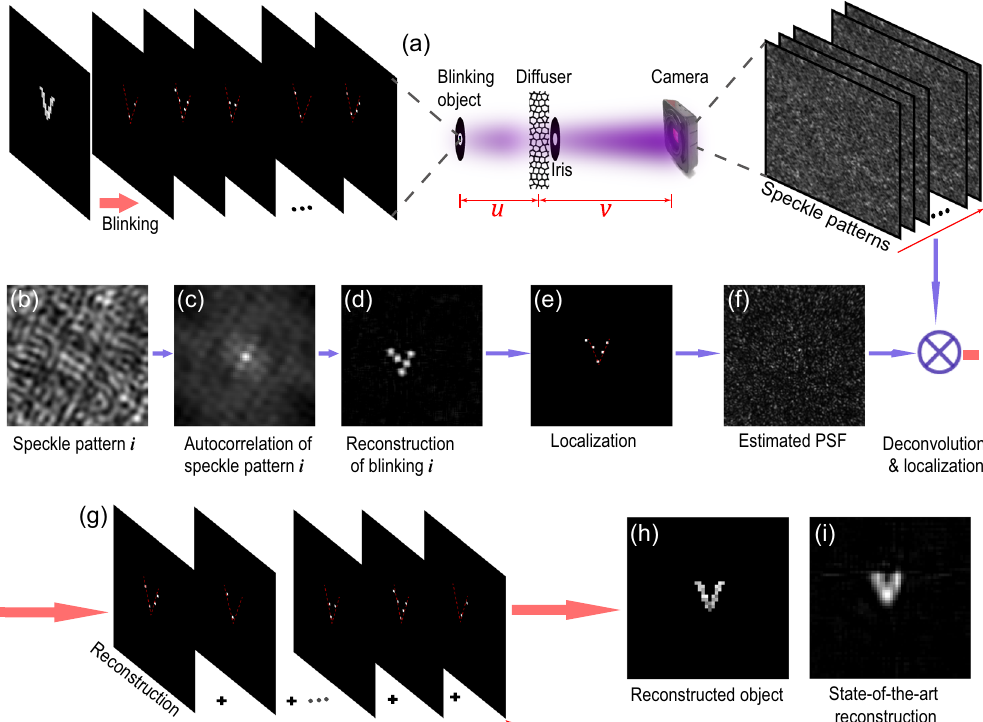
Fig. 2 Principle and simulation results of SOSLI. a Object constitutes many intermittent point sources behind an optical diffuser; the iris de fi nes the optical aperture of the imaging system, and the camera captures speckle patterns. b A small portion of a typical speckle pattern. c Autocorrelation of the speckle pattern is similar to that of the point source pattern. d A retrieved image from its autocorrelation. e Localized point sources from the retrieved image. f Estimated PSF ’ from the localized point source frame ( e ) and its corresponding speckle pattern ( b ). g A series of localized point source images by deconvolution of the speckle patterns with the estimated PSF ’ . h A reconstructed image with a sub-diffraction-limit resolution by superposing all the individual localized source images. i A retrieved image from a single-shot speckle pattern when all point sources are on, i.e., the current state-of-art non- invasive imaging scheme 33